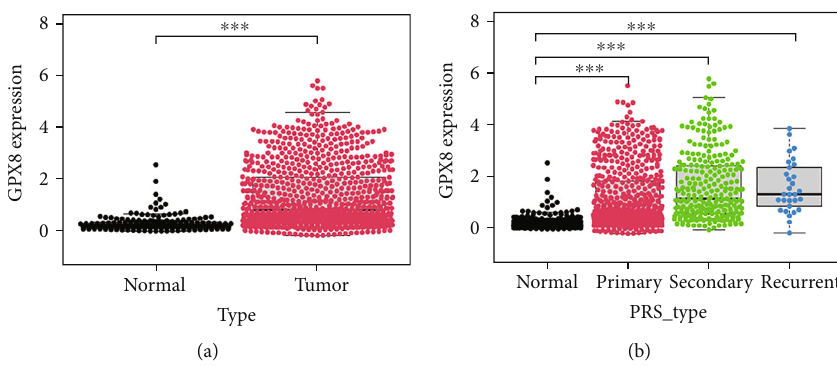
Figure 1: GPX8 expression in glioma and normal brain tissues. (a) GPX8 was highly expressed in gliomas tissues ( n = 925 ) from CGGA compared to normal brain tissues ( n = 207 ) from GTEx. (b) GPX8 expression was increased in primary ( n = 620 ), secondary ( n = 275 ), and recurrent ( n = 30 ) gliomas. ∗∗∗ P < 0 : 001 . Table 1: Characteristics of patients with primary glioma based on